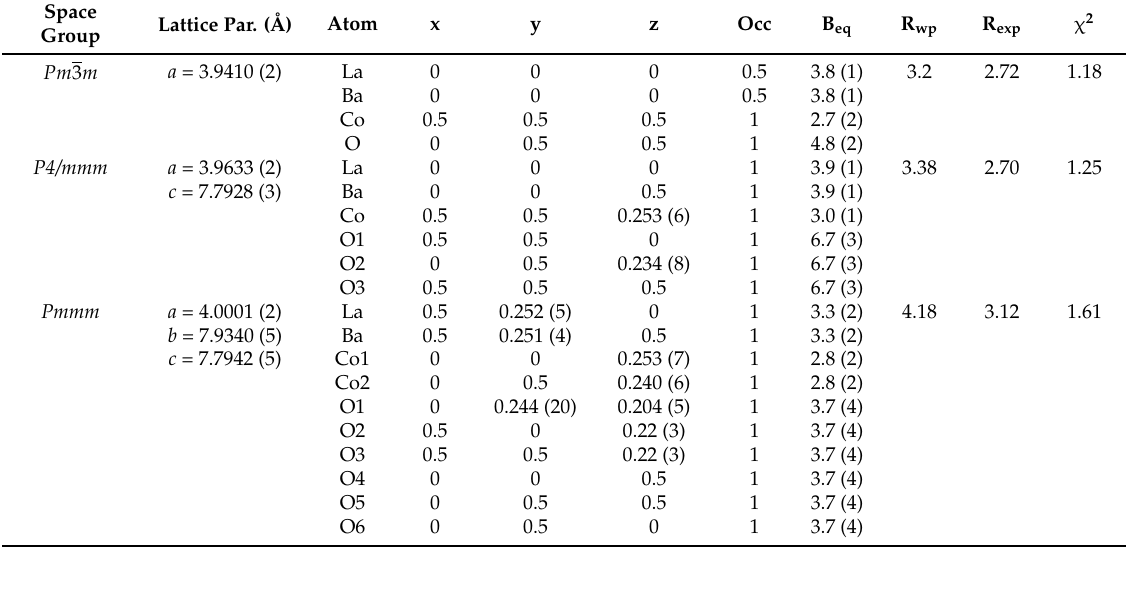
Table 1. Crystallographic data at 600 ˝ C of cubic La 0.5 Ba 0.5 CoO 3 ´ δ and tetragonal LaBaCo 2 O 5 ` δ in O 2 ; and orthorhombic LaBaCo 2 O 5 ` δ in N 2 : lattice parameters, atomic positions, occupancies, thermal